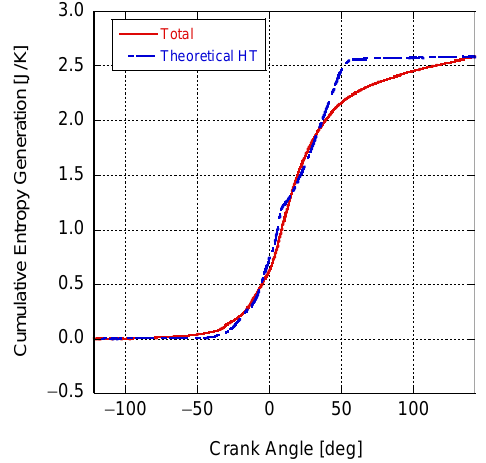
Figure 13. Cumulative entropy generation computed using the conservation of entropy equation and using a theoretical heat transfer based on the theoretical heat release.